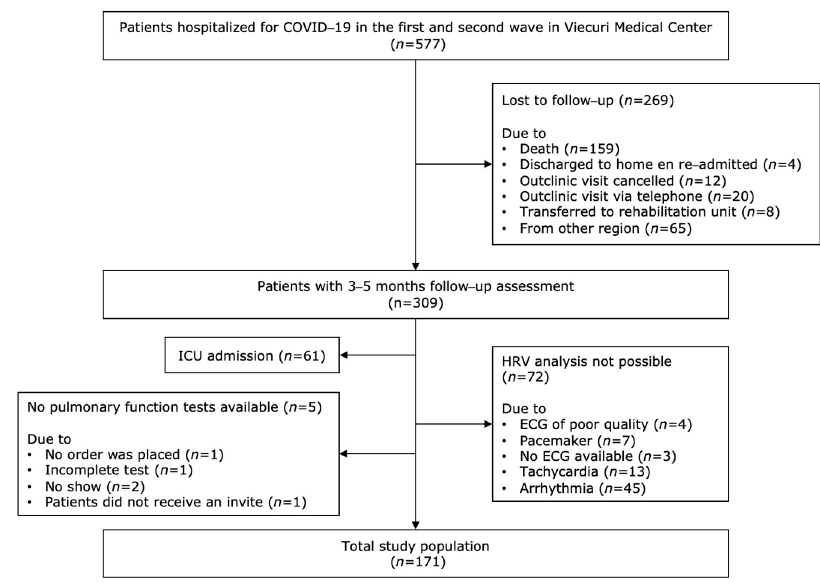
Figure 1. Study flow chart.